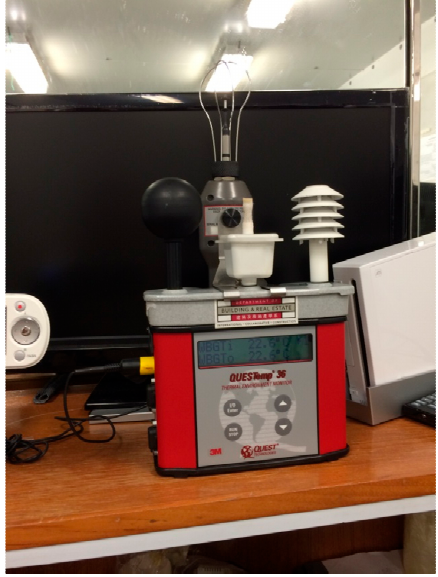
Figure 1. Heat stress monitor (QUESTemp° 36, 3M, North Ryde, Australia).